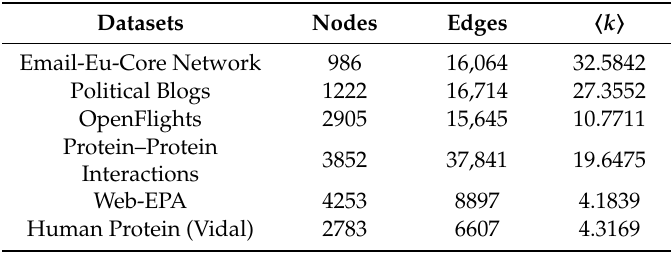
Table 1. Datasets for verifying propagation influence. Datasets Nodes Edges (cid:60) k